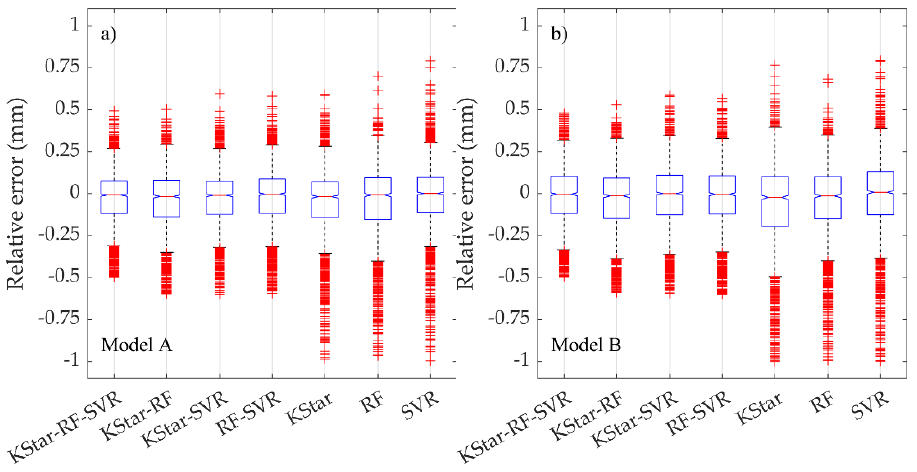
Figure 8. Box plots of the relative errors: a) Model A and b) Model B